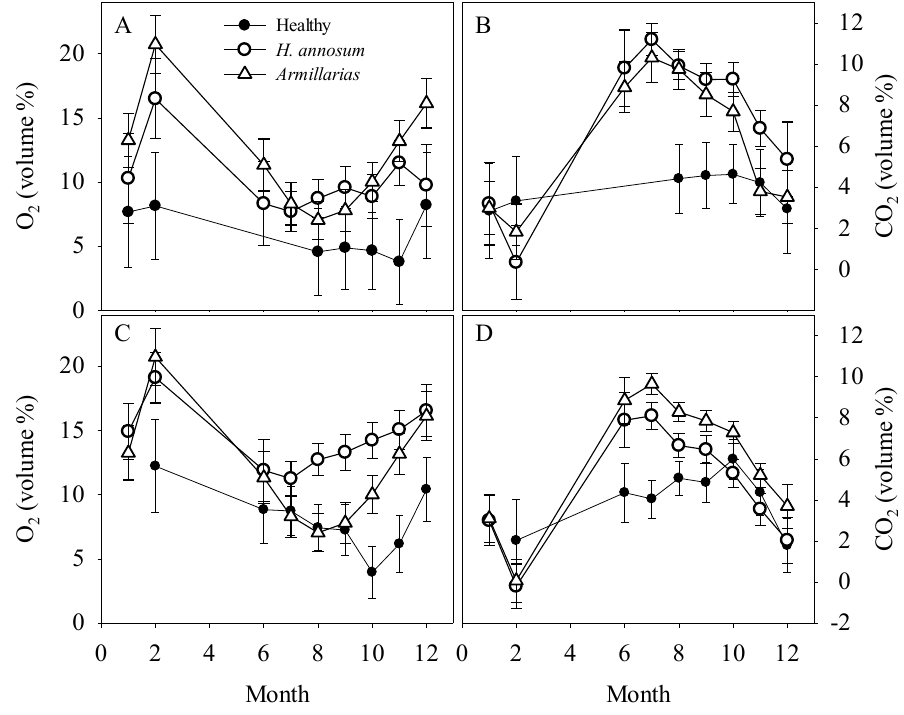
Figure 1. Least square means of monthly O 2 concentrations measured at breast height ( A ), and stump height ( C ), and the corresponding concentrations of CO 2 ( B ) and ( D ) in four healthy trees, six trees infected by Heterobasidion annosum s.l. and five trees infected by Armillaria species. Error bars are ±1 standard error. The total number of observations is 510. The data are from two sites, Ås and Hokksund, where mean age of the trees was 110 and 54 years, mean tree height 25.6 and 22.9 m, and mean stem diameter at breast height 38.2 and 26.2 cm,